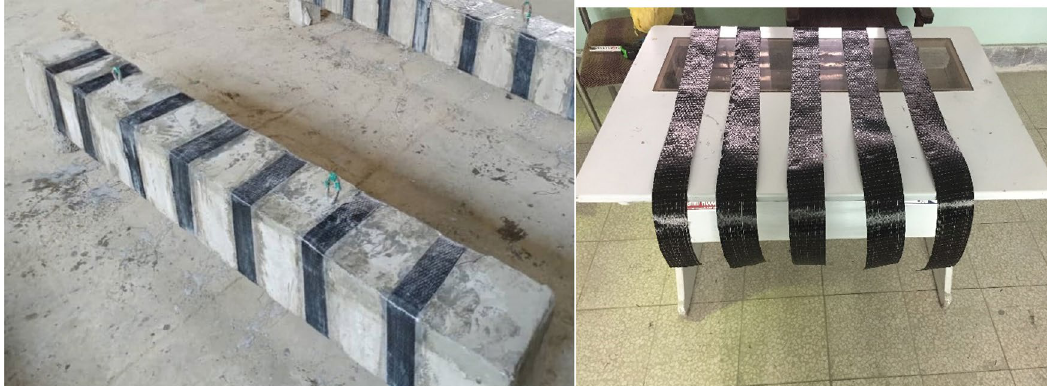
Fig. 4 FRP strips preparation Table 2 Test results for RC beam specimens Specimen Load corresponding to Maximum deflection in the mid- the first crack (kN) dle point of the beam (mm)